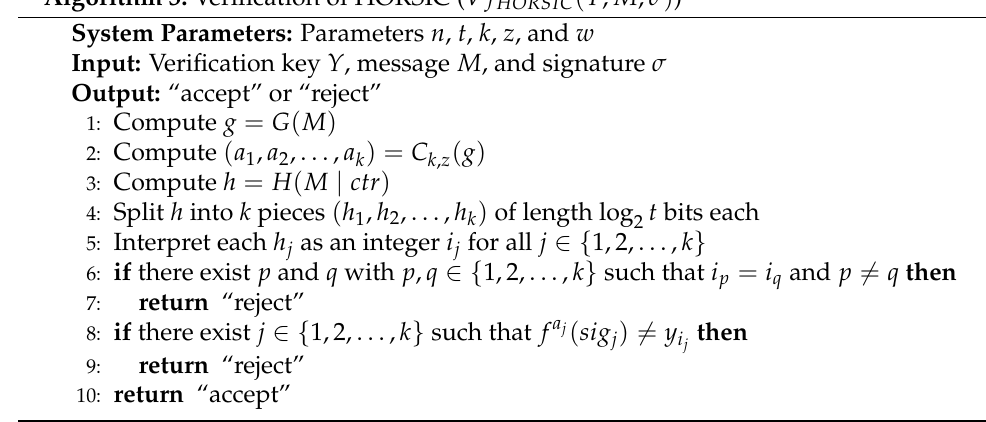
Algorithm 3: Verification of HORSIC ( V f HORSIC ( Y , M , σ )